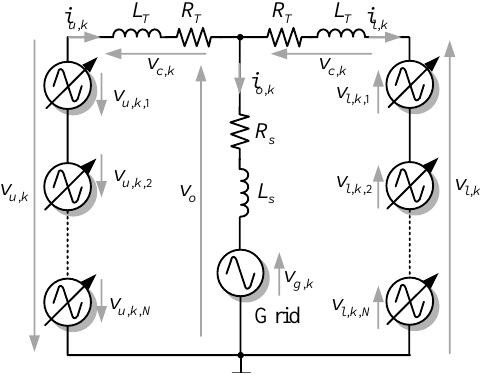
Figure 2. Equivalent electrical circuit per